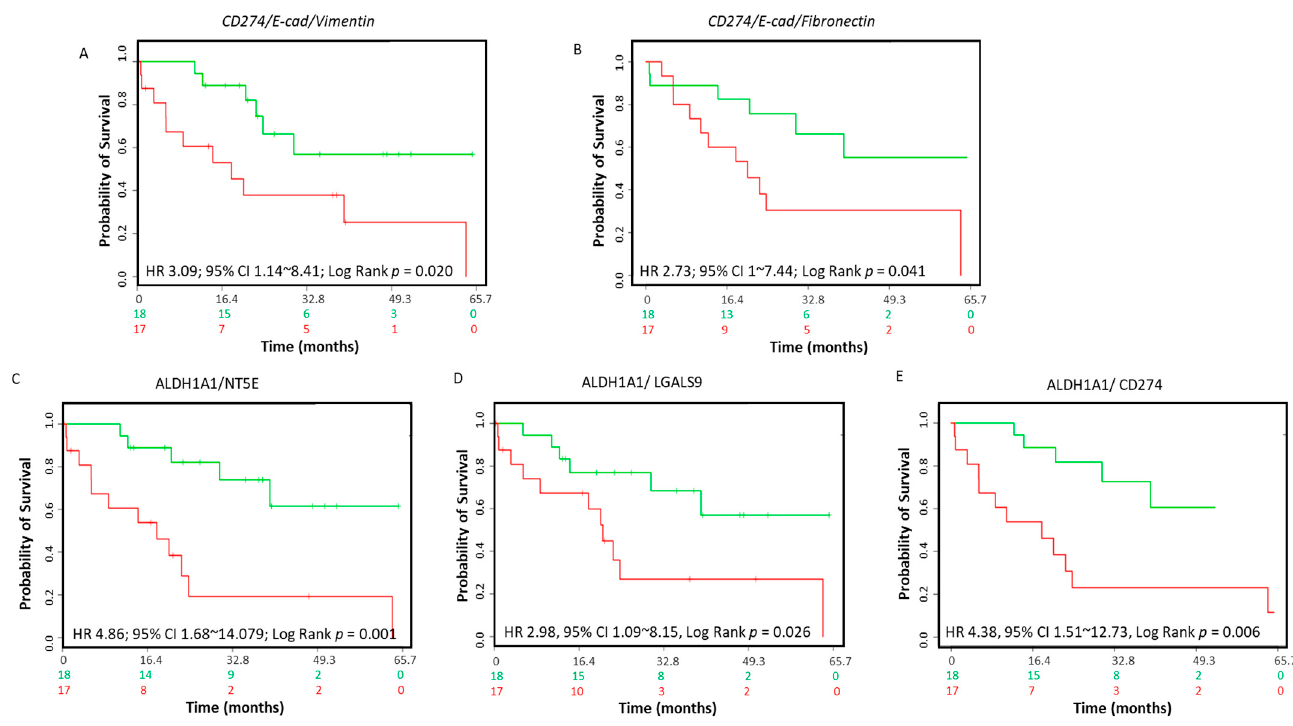
Figure 9. Association between immune modulators, EMT markers, CSC markers and survival in CCA patients. The Kaplan–Meier survival curves in SurvExpress CCA patients for the gene expression of ( A ) CD274 / E-Cad / Vimentin , ( B ) CD274 / E-Cad / Fibronectin , ( C ) ALDH1A1 / NT5E , ( D ) ALDH1A1 / LGALS9 , ( E ) ALDH1A1 / CD274 in CCA patients. Low-risk groups are indicated in green and high-risk groups are indicated in red. The x-axis presents the study time in months. HR, CI and p -values are shown in the insert.